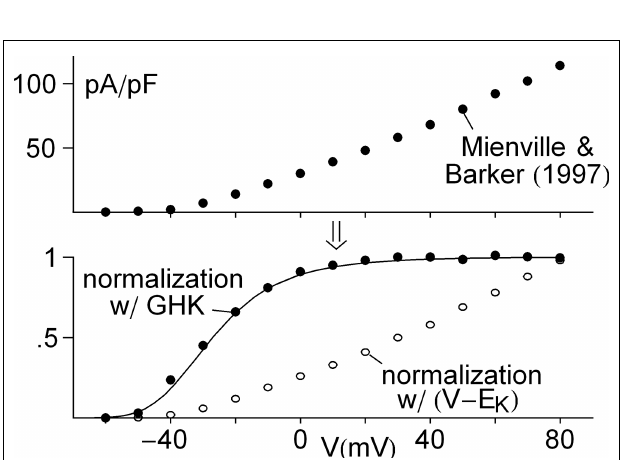
FIGURE 5 | Normalization of squid I The curve describing these results ( n V ∞ 4 ( ) revised) corresponds to ( α where α = 0.01( V + 50)/(exp( − 0.1( V + 50)) − 1) and β n exp( − ( V + 60)/20). The curve labeled HH n ∞ 4 is given by the same equation with β = 0.125 exp( − ( V + n